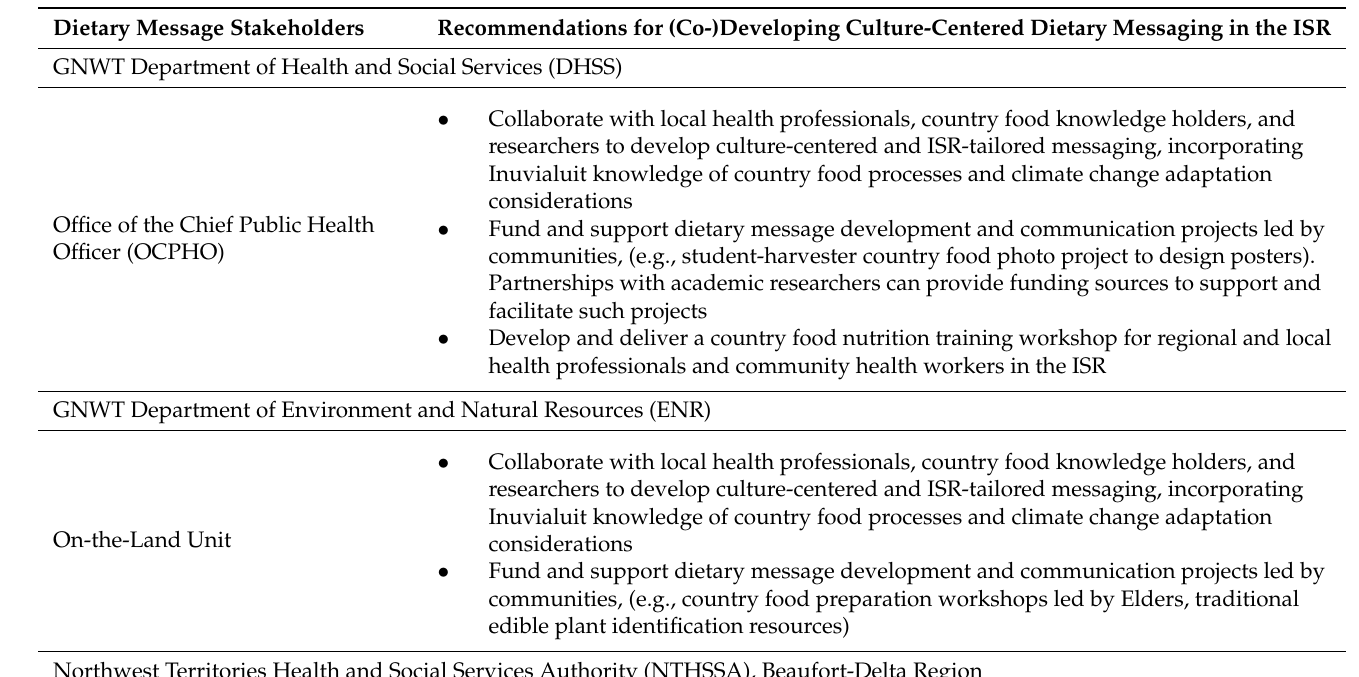
Table 4. Recommendations for collaboratively developing dietary messages in, for, and with the Inuvialuit Settlement Region (ISR), by stakeholder